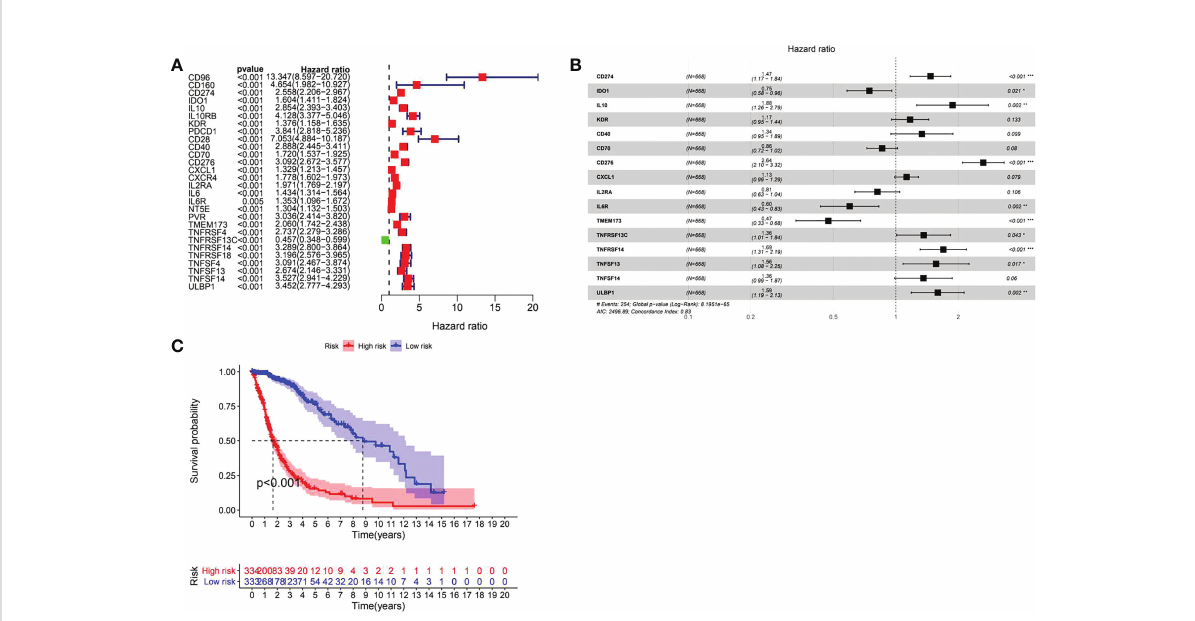
FIGURE 13 Prognostic evaluation of immune genes for glioma. (A) Related immune genes with signi fi cant prognosis in glioma. (B) Prognostic gene model construction. Shows that CD274, IL10, CD276, TNFRSF13C, TNFRSF14, TNFRSF13, ULBP1 are poor prognostic factors for patients with glioma, IDO1, IL6R, and TMEM173 are protective factors for glioma. (C) The prognostic survival analysis of immune genes for glioma showed that the high expression group is not conducive to the survival of glioma